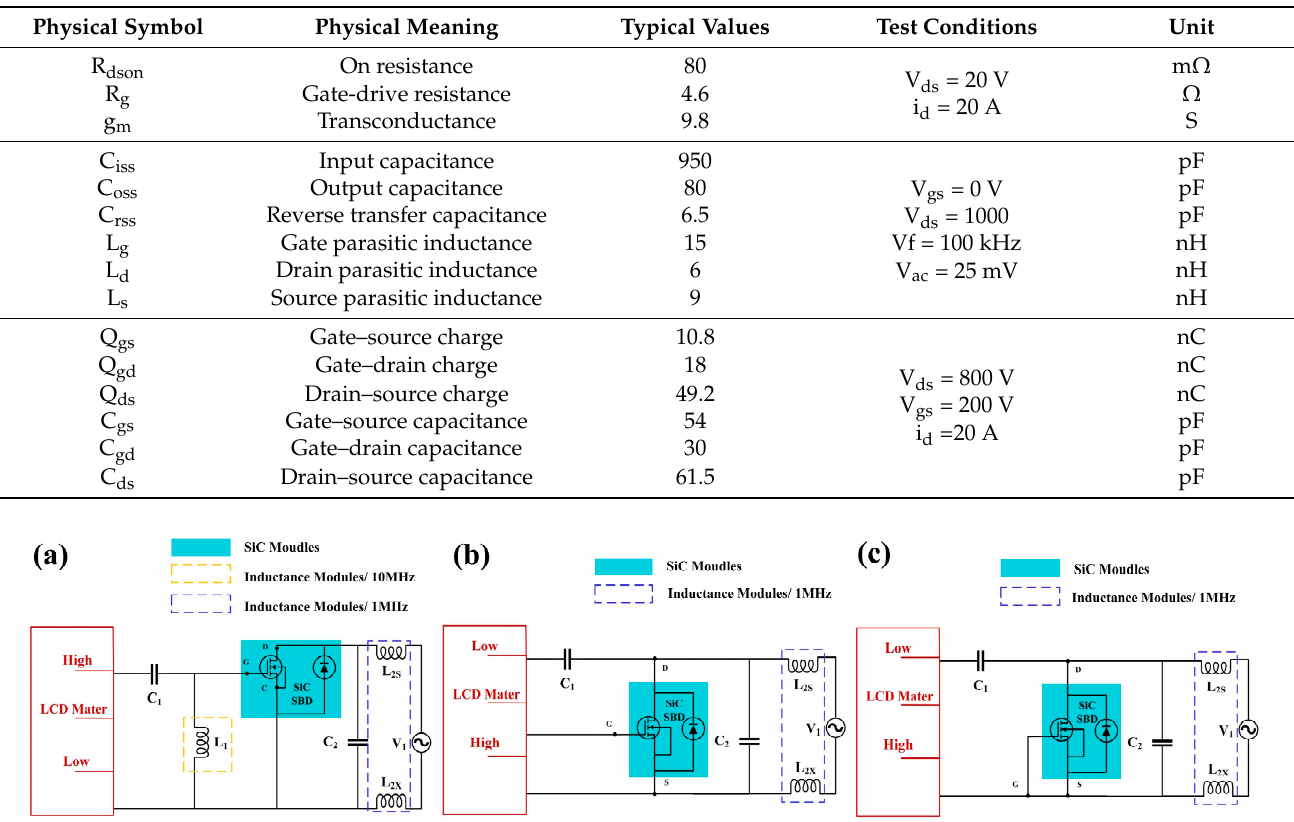
Figure 2. Test circuit for relevant parasitic parameters of high-frequency SiC modules: ( a ) input capacitance test circuit; ( b ) output capacitance test circuit; and ( c ) reverse transmission capacitance test